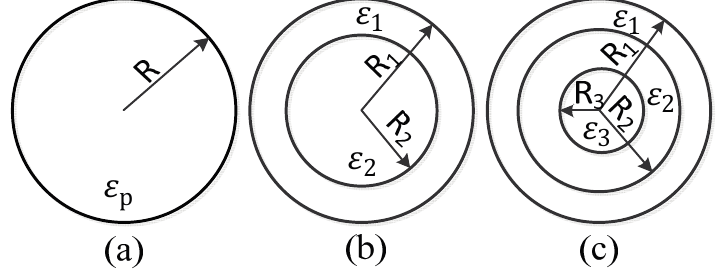
Figure 1. Spherical model. ( a ) Single-shell; ( b ) dual-shell; ( c )